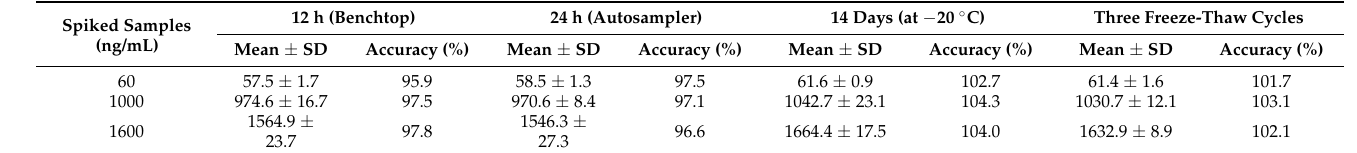
Table 3. Stability of CPPU ( n =